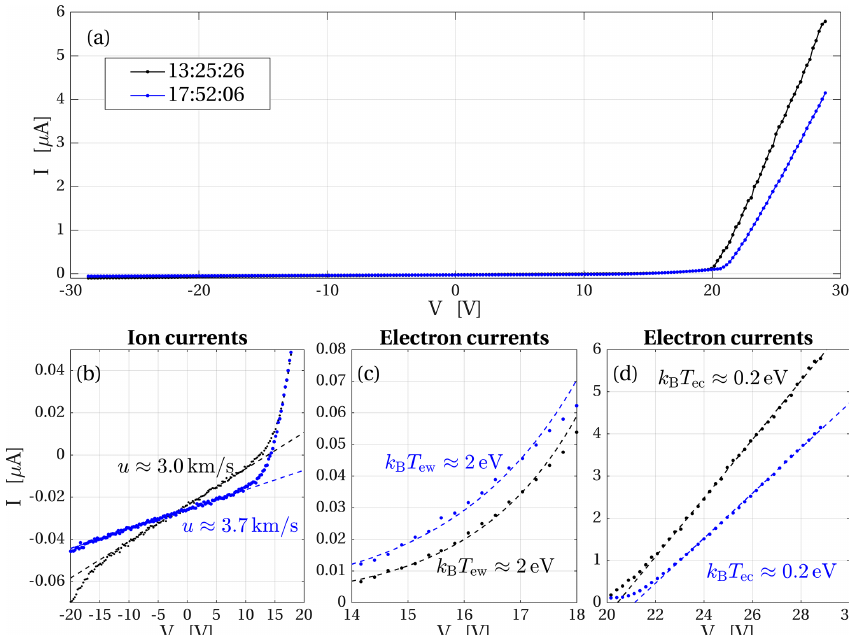
Figure 4. I – V traces from RPC-LAP near closest approach (black) and during the outbound part of the flyby (blue). (a) Complete I – V traces. (b) Ion current part of the characteristics and lines fitted to the ion currents in order to find the bulk speed of the cold ion popula- tion. (c) Electron currents and exponentials fitted to determine the warm electron temperature. (d) Electron saturation current part of the characteristics and lines fitted to determine the temperature of the cold electron population.